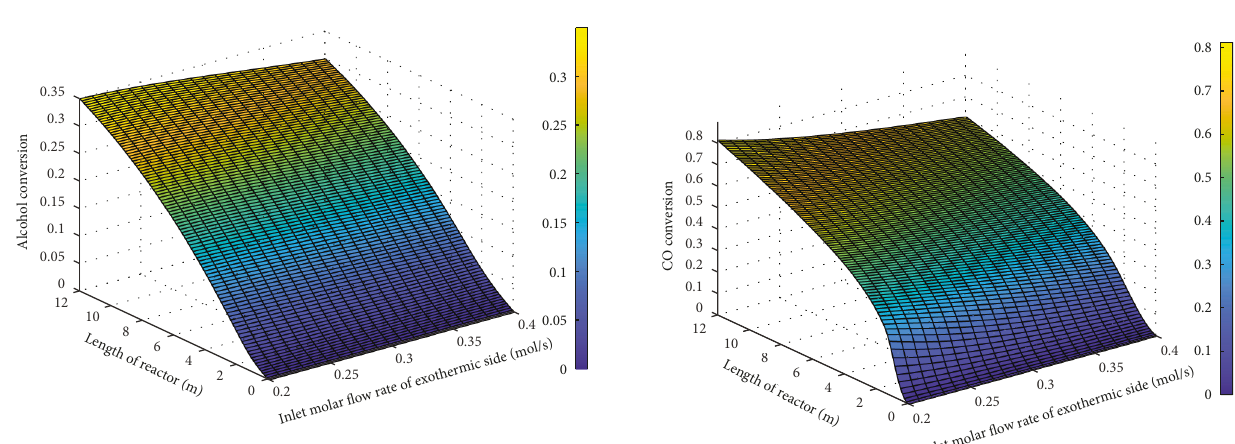
Figure 8: Effect of molar flow rate on the exothermic part of the reactor on conversion percentage of 2-butyl alcohol and MEK yield.